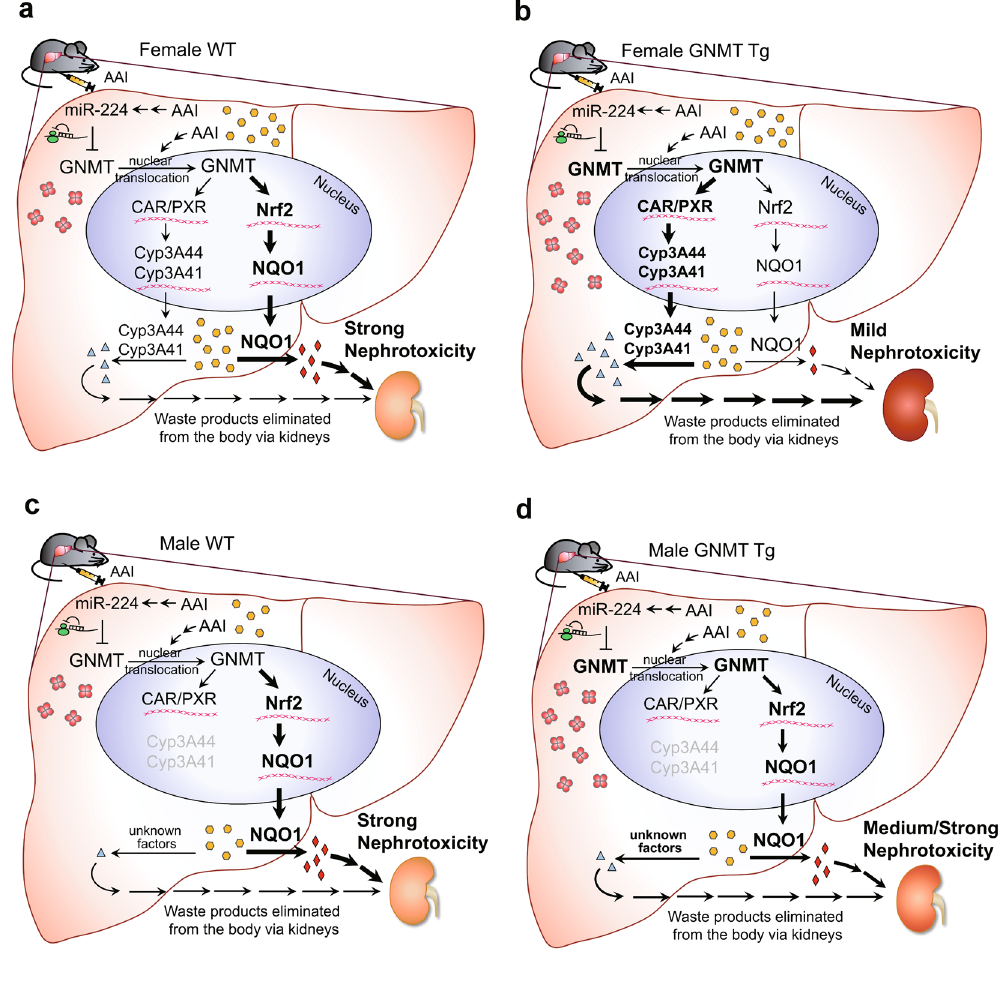
Figure 8. Schematic representation of the role of GNMT in AAI metabolism. The proposed metabolic pathways of AAI regulated by GNMT in liver of 5 mg/kg/day AAI-treated female WT mice (a) and GNMT Tg mice ( b ); and in 2 mg/kg/day AAI-treated male WT mice ( c ) and GNMT Tg mice ( d